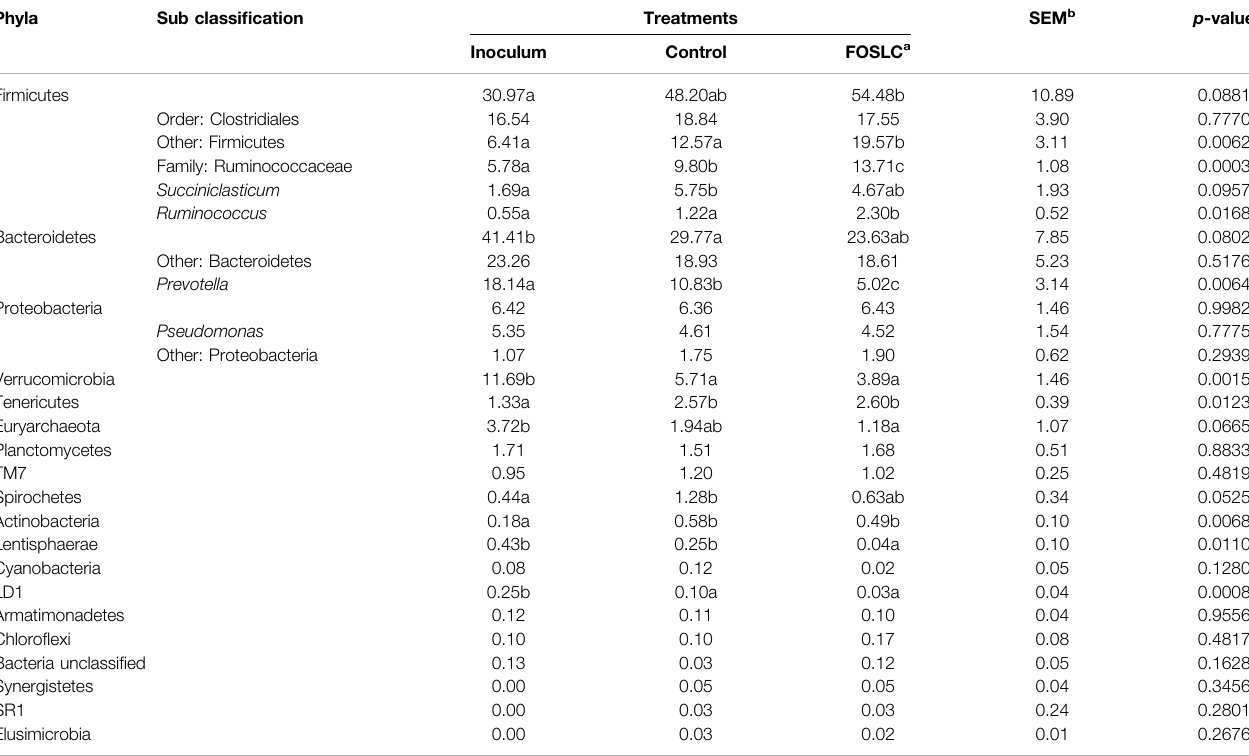
TABLE 3 | Relative abundance of bacteria and archaea of rumen fermentation in the following treatments: inoculum, control, and fermented oat straw as lovastatin carrier 150 mg L − 1 . Phyla Sub classi fi